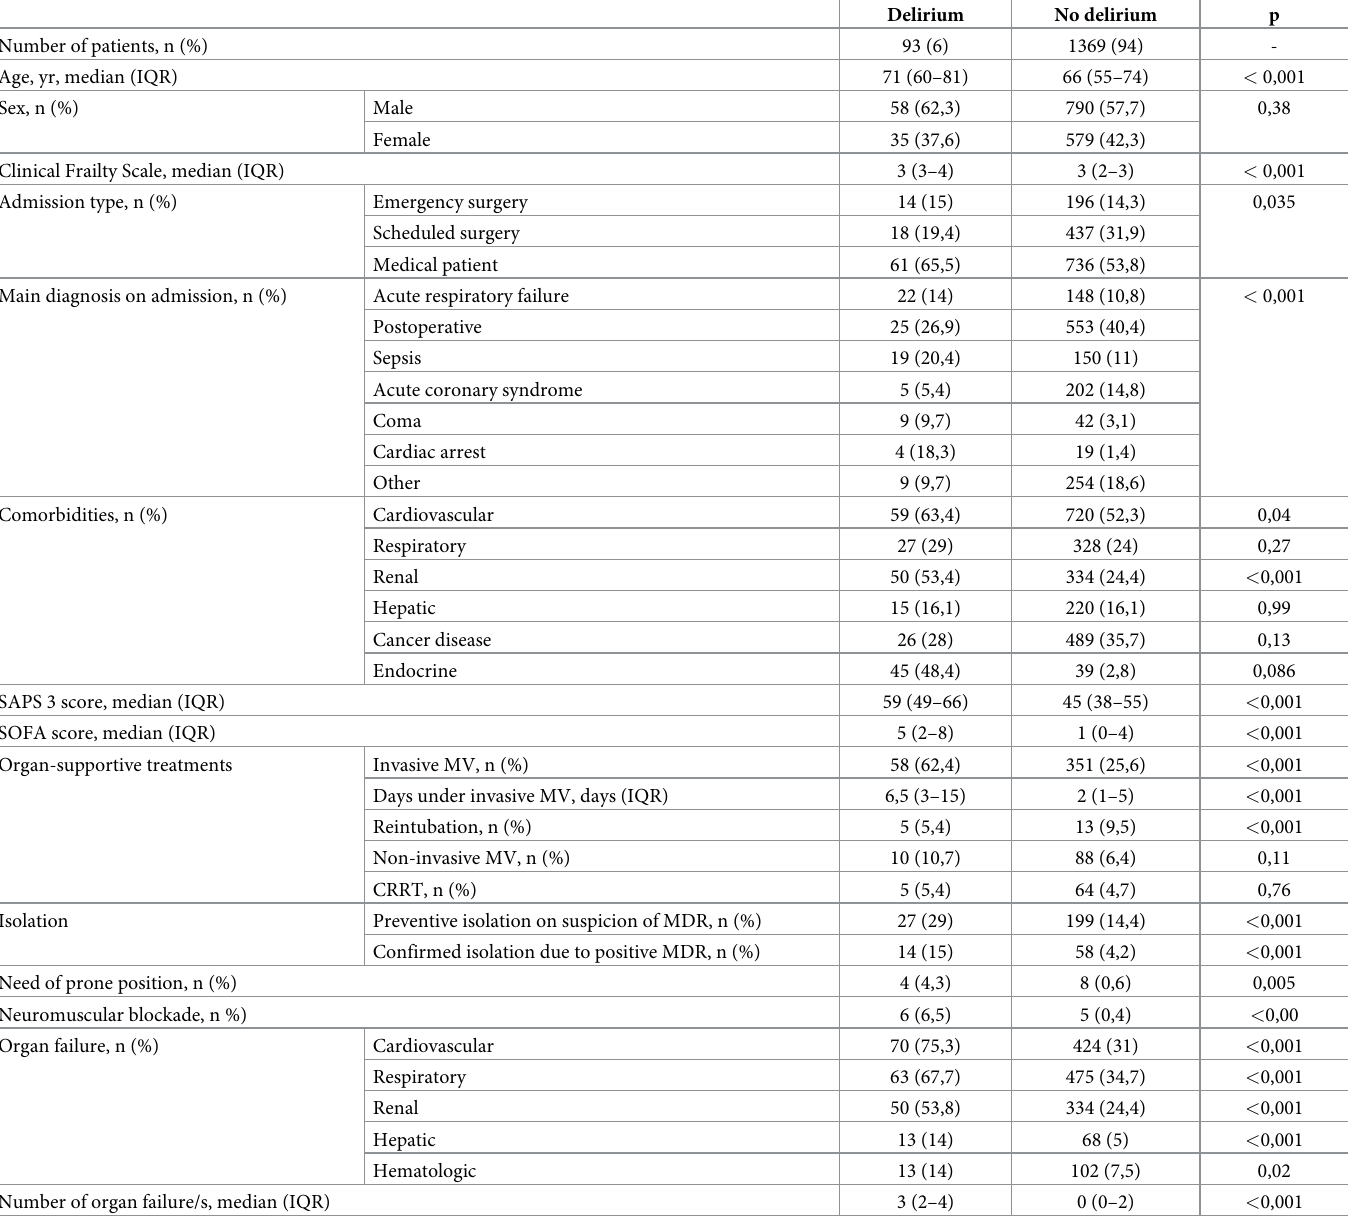
Table 1. Demographics and clinical characteristics of the studied